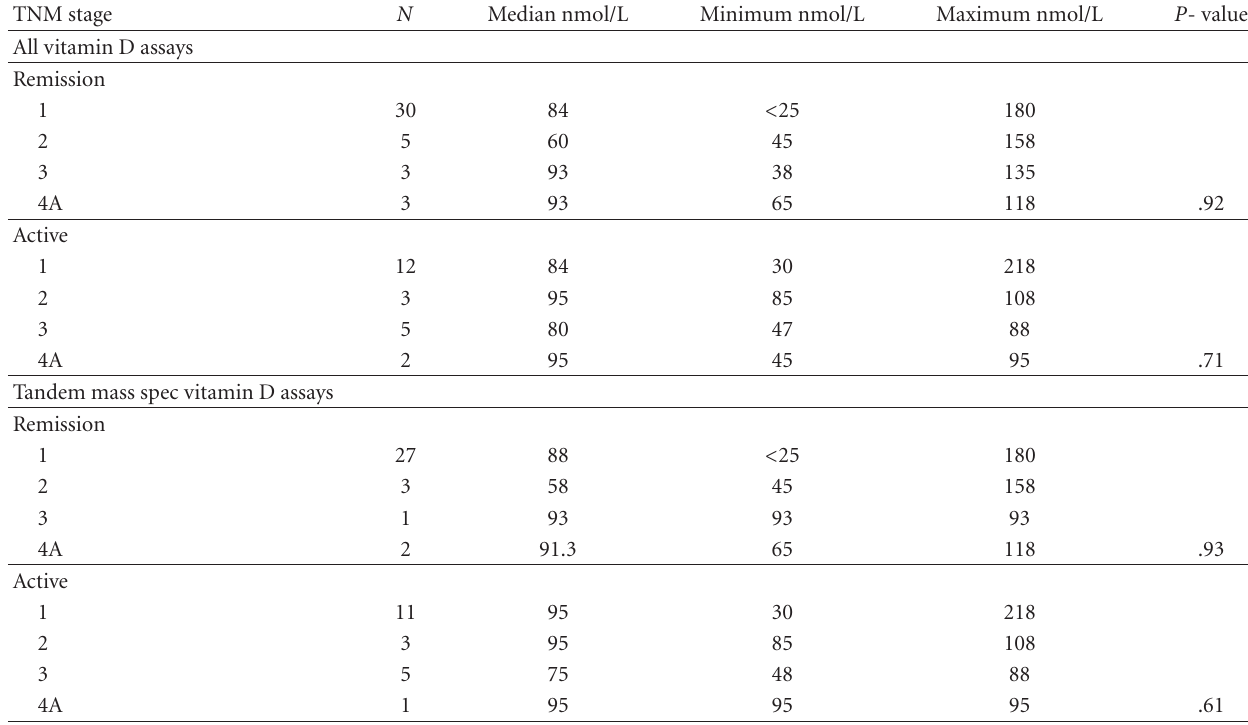
Table 3: Thyroid Cancer Stage and Median 25-OH-D levels.